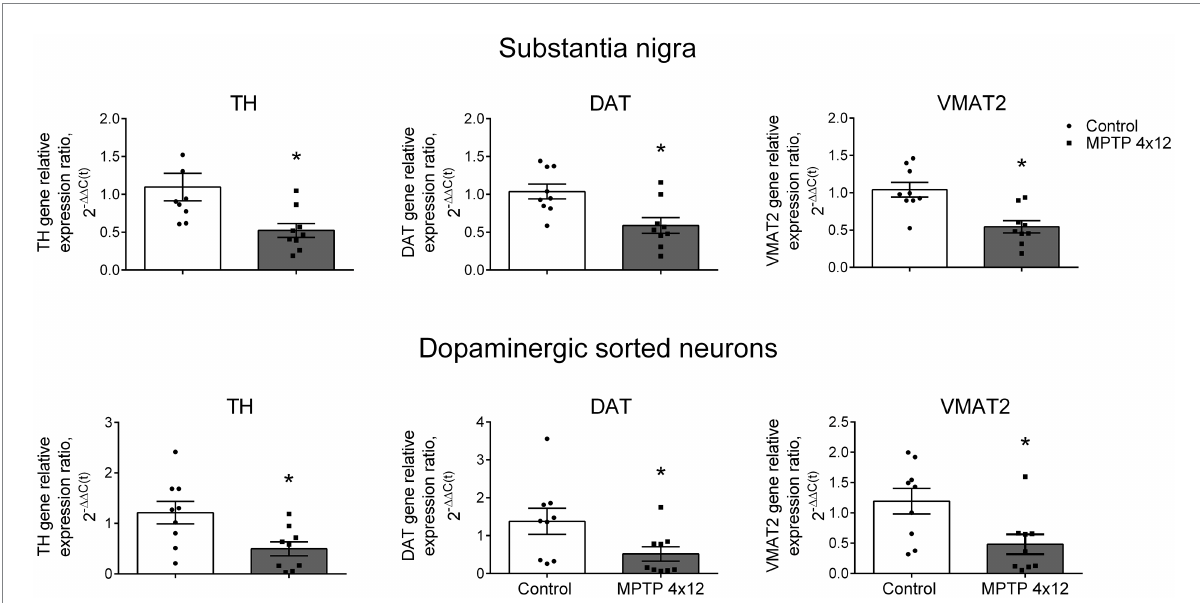
FIGURE 7 Expression of genes in the whole substantia nigra and sorted dopaminergic neurons in 1-methyl-4-phenyl-1,2,3,6-tetrahydropyridine (MPTP)- treated mice. Expression of the tyrosine hydroxylase (TH) gene, dopamine transporter (DAT) gene, and vesicular monoamine transporter 2 (VMAT2) gene in the whole substantia nigra (homogenate) and sorted dopaminergic neurons in mice 3 weeks after 4-fold administration of MPTP in a single dose of 12 mg/kg, or saline in control. Groups were compared for normality by using the D’Agostino & Pearson test. Statistics indicate significance by the unpaired t -test or Mann–Whitney test, depending on the type of distribution (* p < 0.05 compared with the control group). Data are presented as mean ± SEM. n = 9 for each